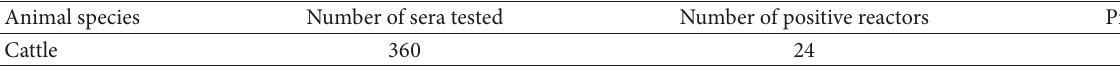
Table 2: Overall seroprevalence of brucellosis in cattle.